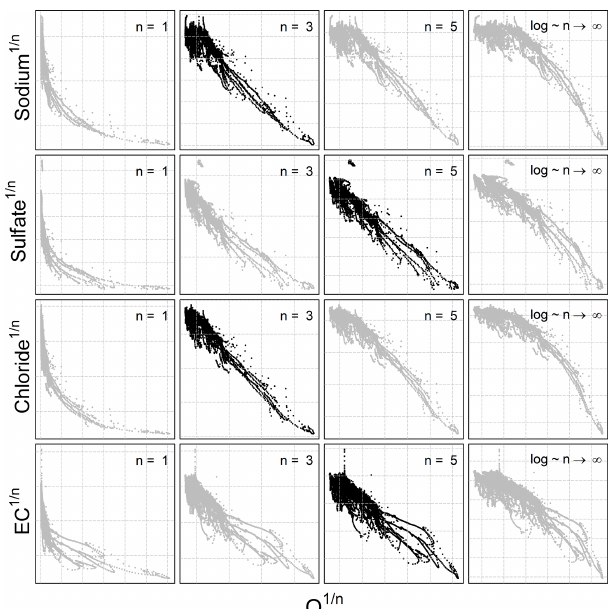
Figure 3. C – Q behavior of three different chemical species and the electrical conductivity with different 2S-APS transformations ( n = 1, 3, 5, and log). The optimal power parameter (black dots) was chosen based on the R 2 criterion. Note that we have removed the scale on the axes to focus only on the change in shape in the C – Q